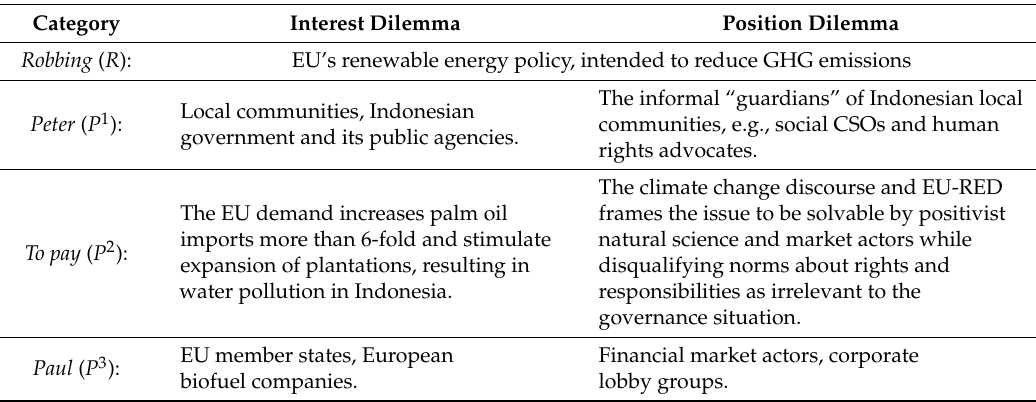
Table 3. Application of the RP3 idiom to the Renewable Energy Directive